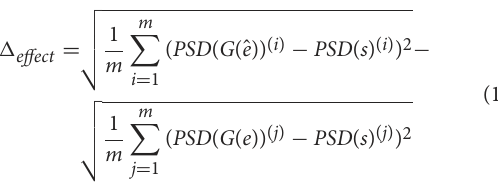
the phase was kept unperturbed. RMSE of PSD is computed with the perturbed EEG e as input. Changes compared to the ˆ unperturbed result were computed to indicate the effect 1 effect of